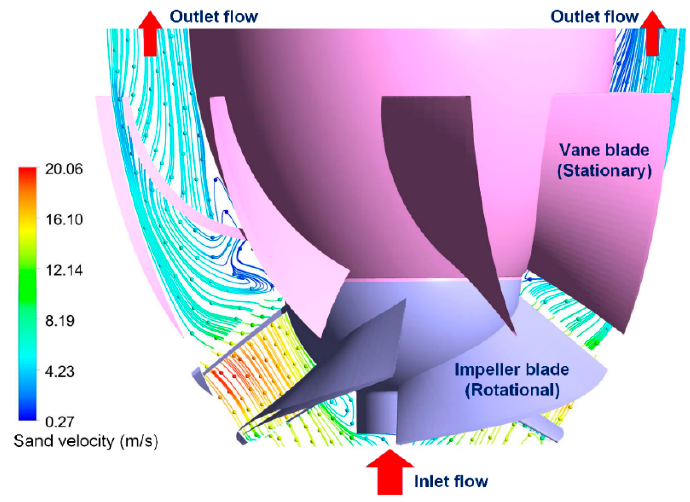
Figure 7. Flow patterns in the pump on an azimuthal plane at the design flow rate.